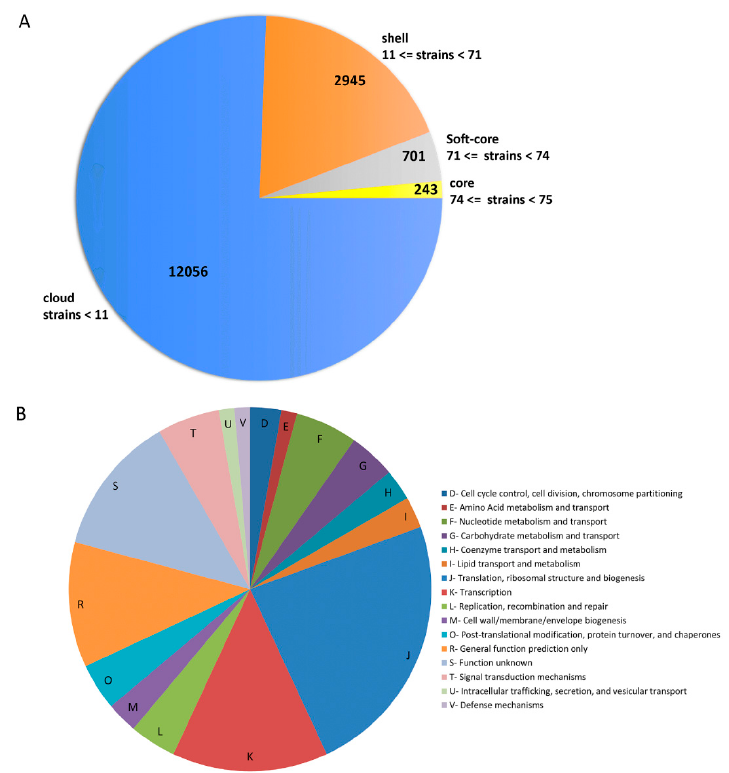
Figure 3. Pan-genome analysis of 75 L. paracasei strains. ( A ) Pie-chart representing core and accessory genes distribution. ( B ) Pie-chart representing the distribution of COG categories of 243 core-gene families.